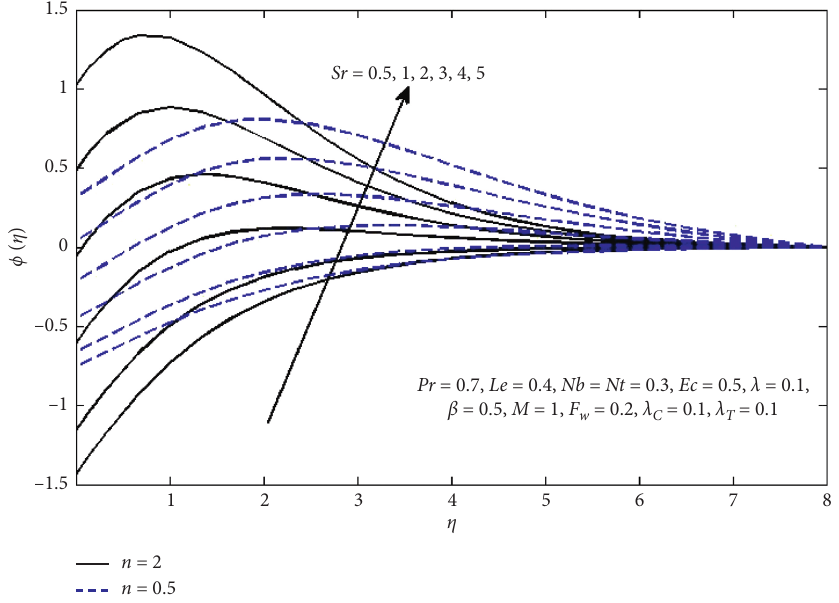
Figure 19: Variation of concentration ϕ concerning η with various values of Sr ( n � 2 __, n � 0.5 ---).